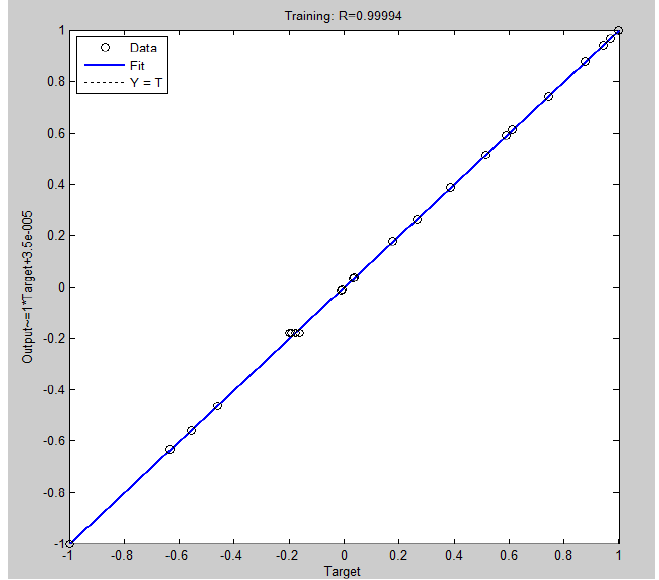
Figure 11. Regression plot (Actual vs. Predicted) using the ANN model.